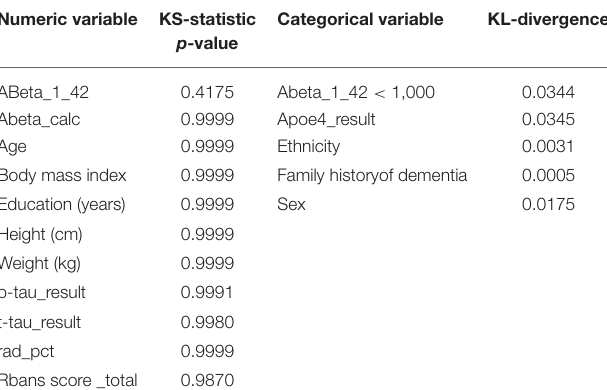
TABLE 2 | Measures of statistical fidelity of the synthetic data with the real data. Numeric variable KS-statistic Categorical p -value